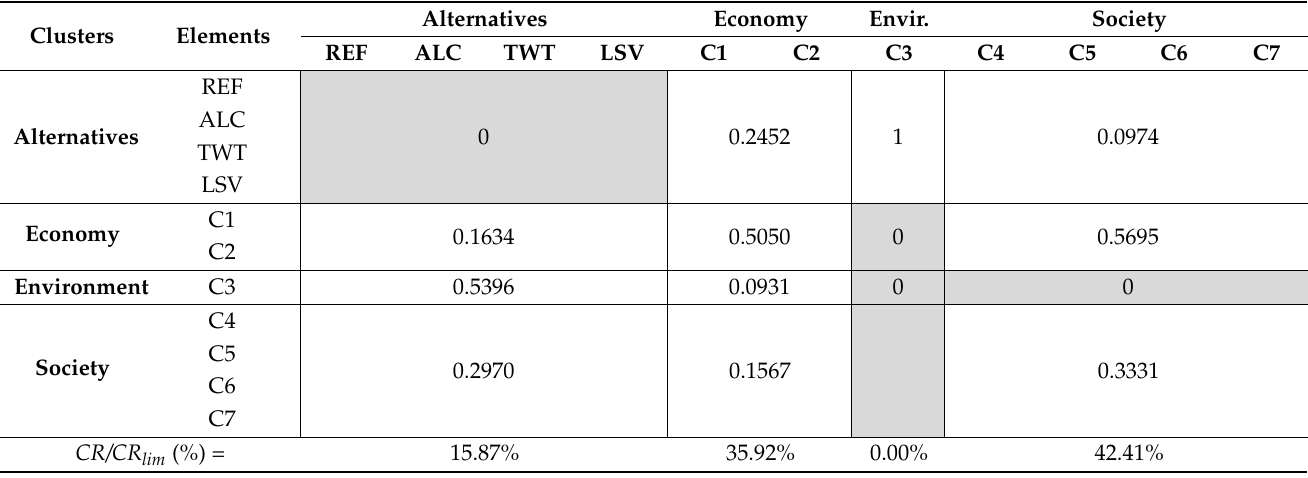
Table 7. Weight of each cluster from DM 1.